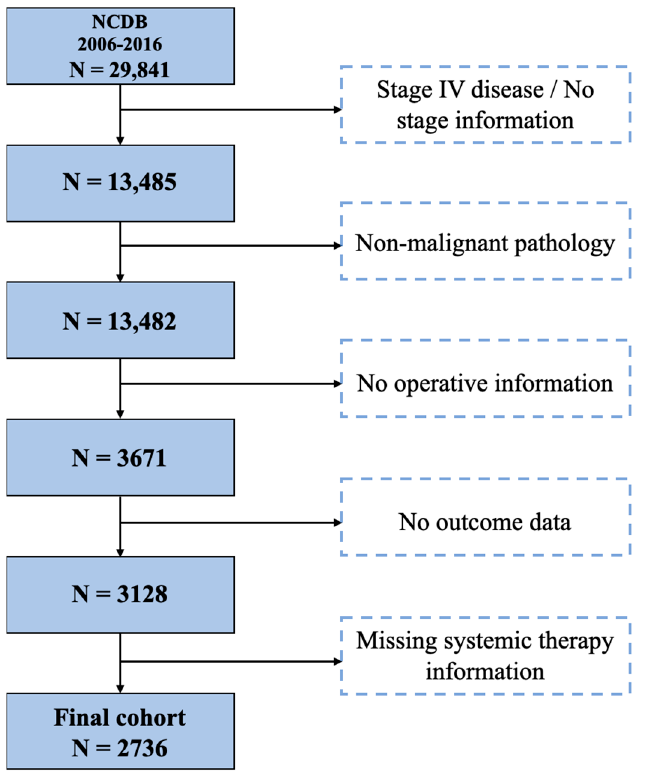
Figure 1. CONSORT flow chart for the selection criteria of patients with intrahepatic cholangiocar- cinoma included in the study population derived from the National Cancer Database. CONSORT: consolidated standards of reporting trials.